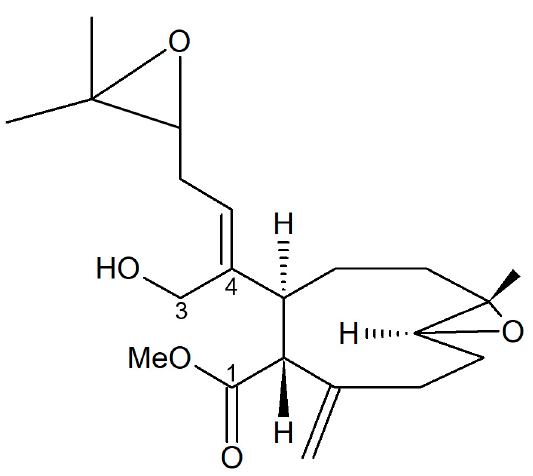
Figure 21. Structure of the diterpene extracted from X. elongata [85].